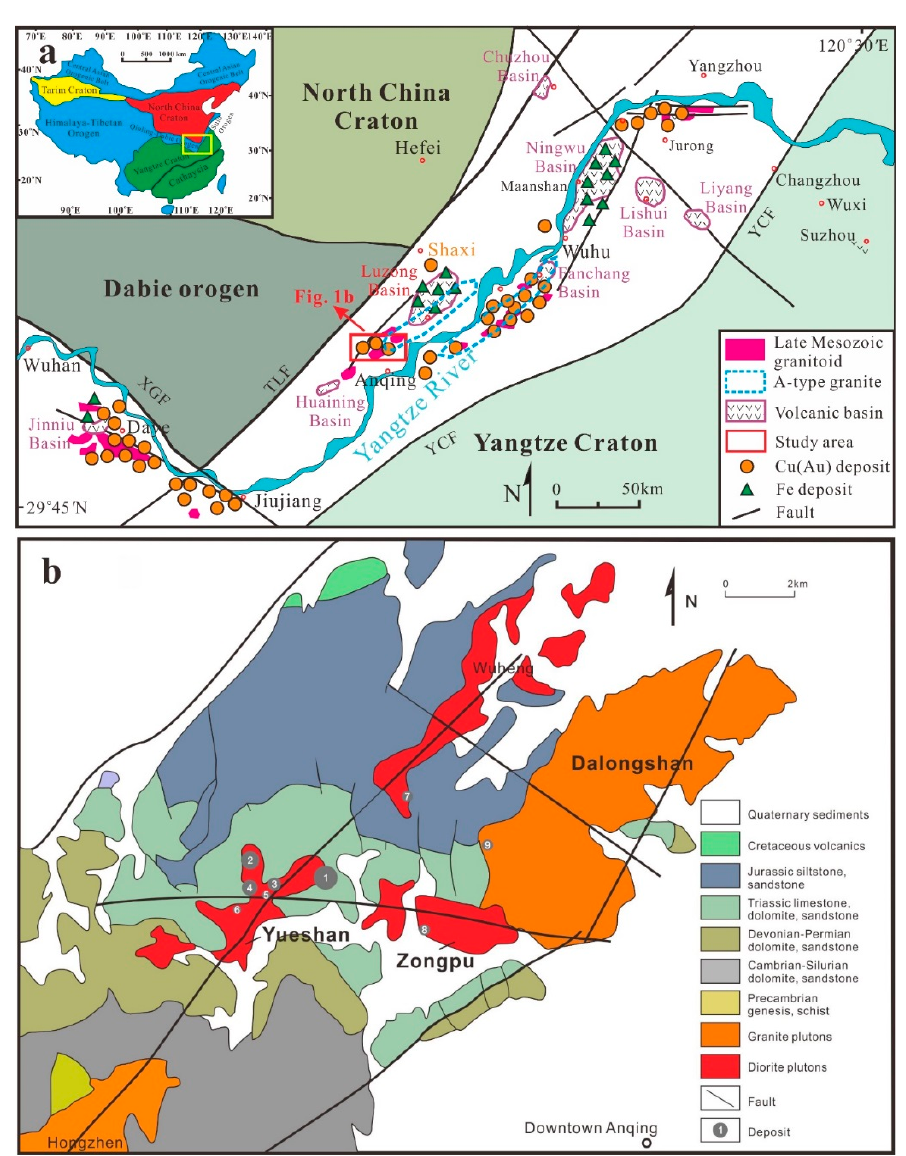
Figure 1. ( a ) Simplified geological map of magmatic rocks and ore deposits in the LRYB (the insert shows the general tectonic divisions of China) (modified after [11,33,34]); ( b ) geological map of the Anqing district, Anhui Province, China (modified after [27]). YCF: Yangxin–Changzhou Fault, XGF: Xiangfan–Guangji Fault, TLF: Tancheng–Lujiang Fault. Ore deposit information: 1—Anqing copper